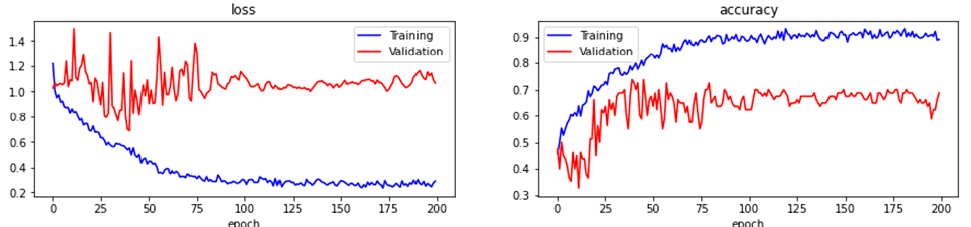
Figure 15. The training loss, validation loss, training accuracy, and validation accuracy of learning rates range from 0.0005 with maximum epochs of 200 and batch size of 16.